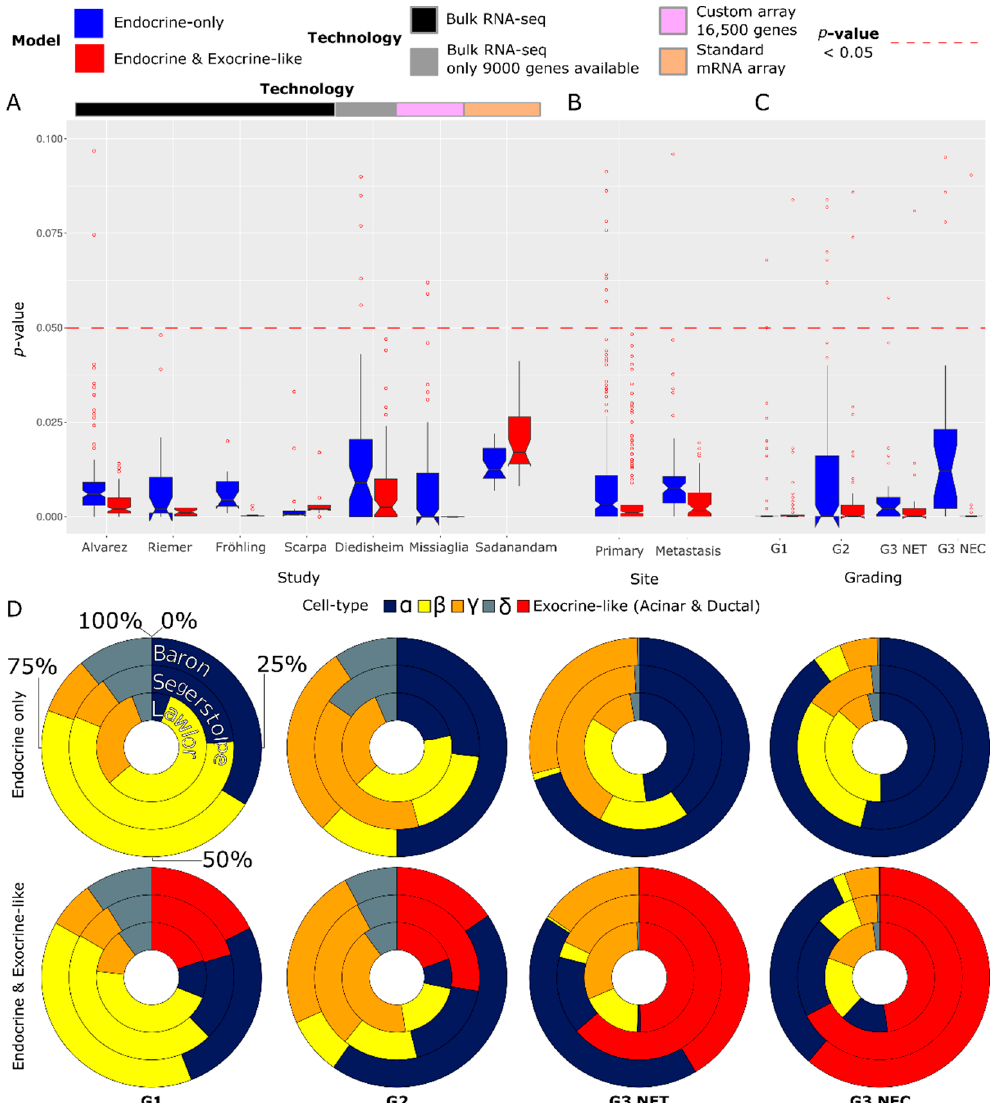
Figure 3. Deconvolution p -values and predicted relative cell type proportions. Plots ( A – C ) show the deconvolution p -value distributions aggregated by study of origin, primary or metastasis status, grading and NEC or NET status. Plot ( D ) shows the relative cell type proportion prediction for the endocrine-only (upper row) and the endocrine exocrine-like mixed model (lower row) aggregated over different gradings and the NEC or NET status.